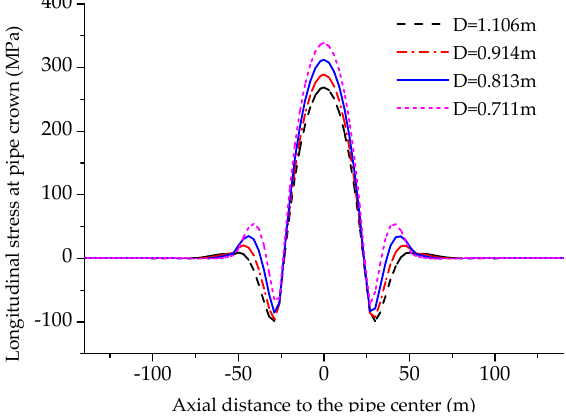
Figure 11. Vertical deformations for pipes with various diameters.